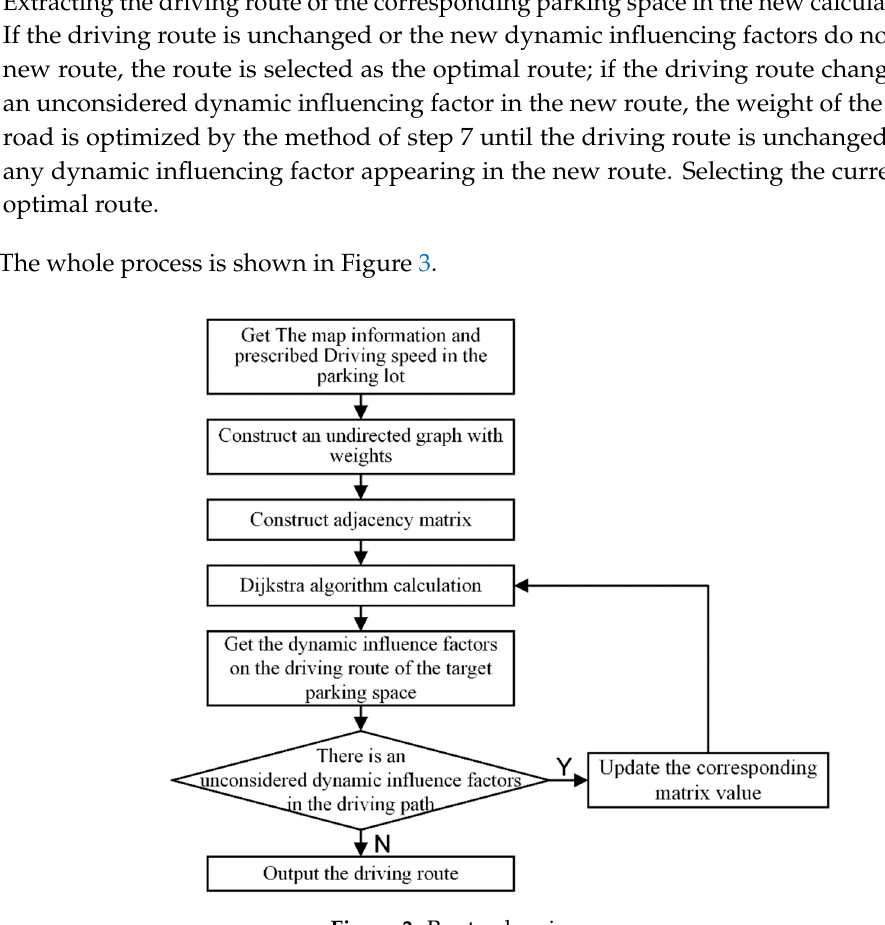
Figure 4. Target parking lot.